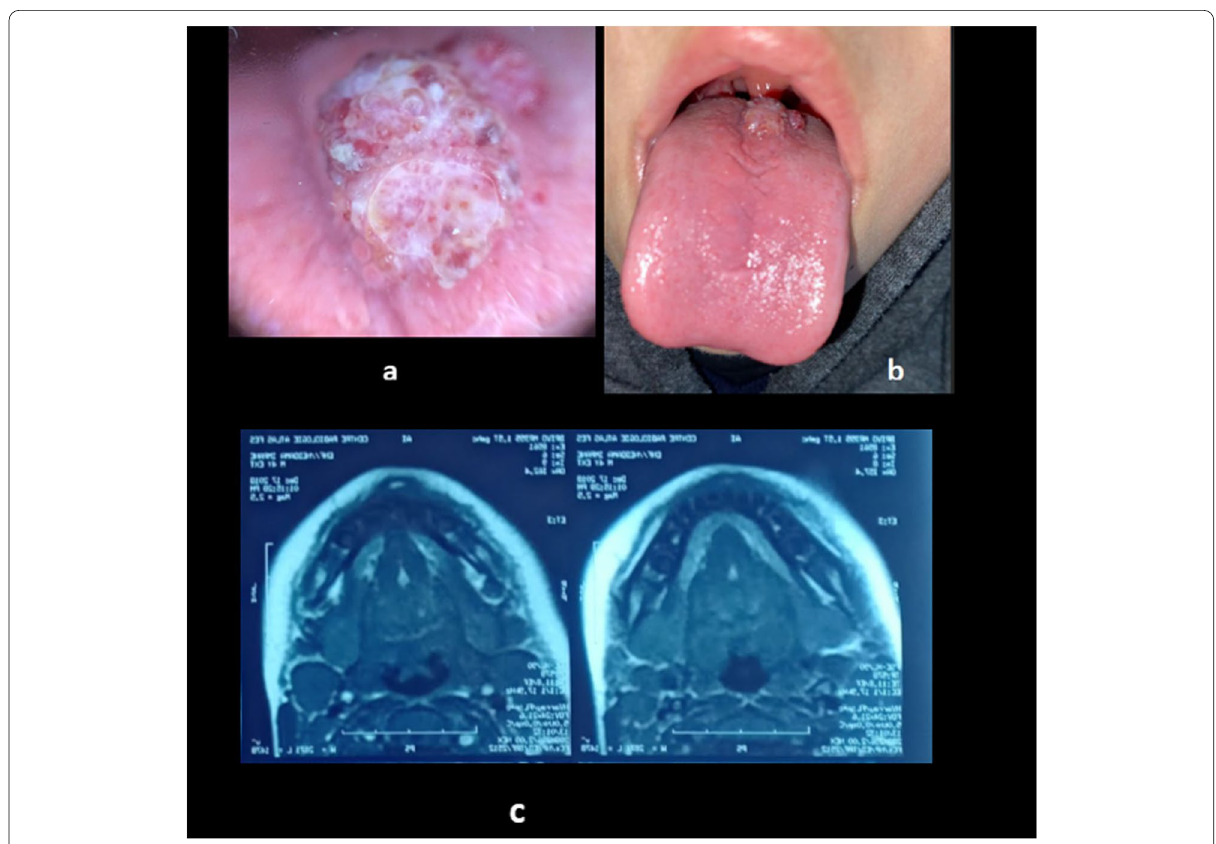
Fig. 1 Clinical and radiological findings in patient 1. a Dermoscopic aspect of the microcystic lymphangioma of the tongue. b Clinical localization of microcystic lesion of the tongue. c Coronal sections of MRI images, showing the lesion in the proximal extremity of the